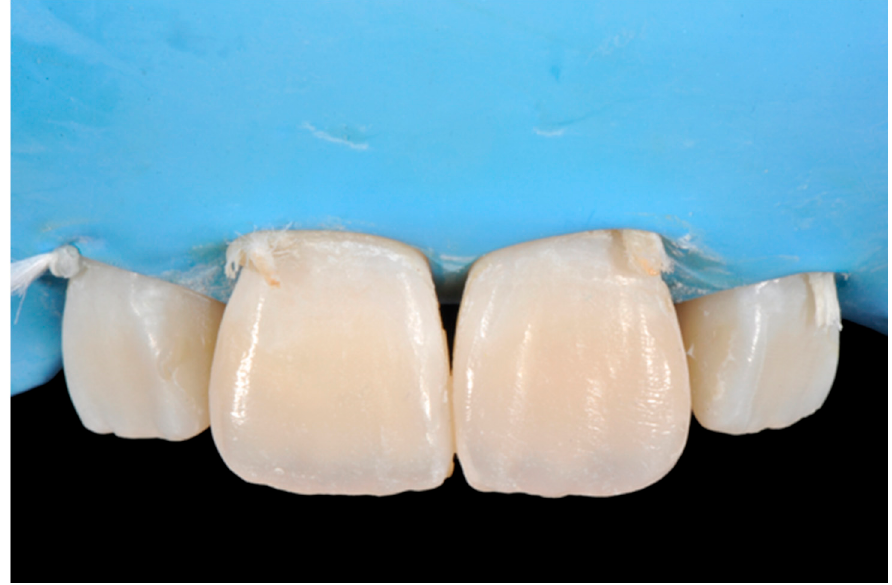
Figure 37. Final result after finishing and polishing. Reprinted from Restauri diretti nei settori anteriori, G. Paolone, S. Scolavino, © 2021, with permission from Quintessence Publishing Italy.